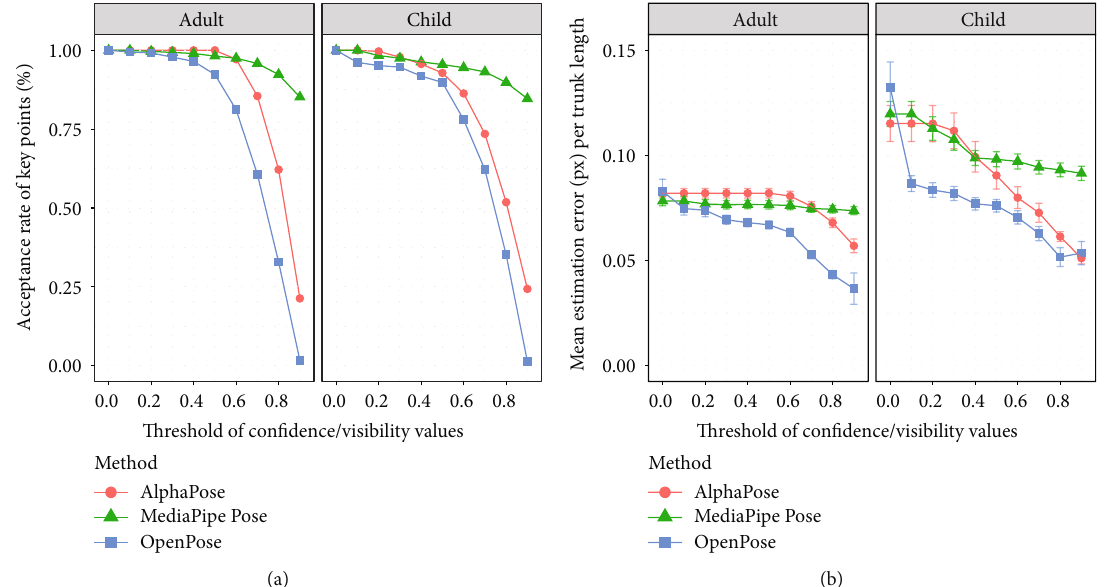
Figure 4: Acceptance rate and estimation error distance of each pose estimation method. Note: error bars indicate standard